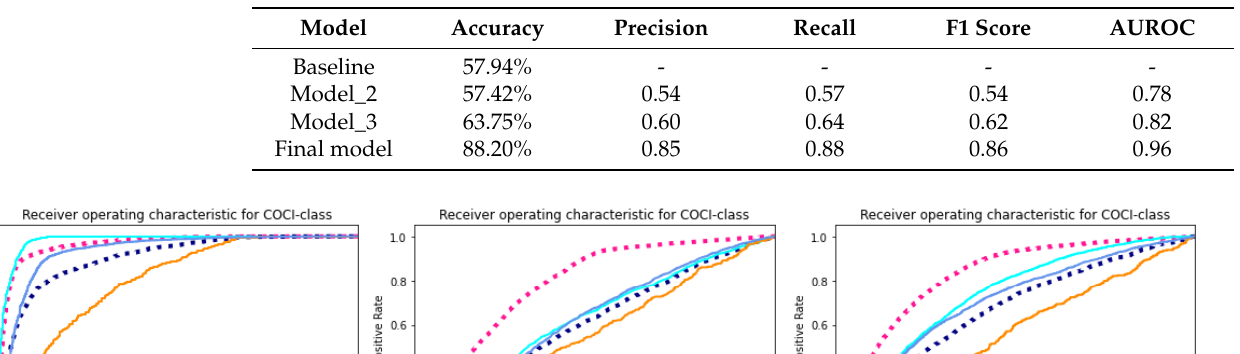
Table 6. Performance results between the final and compared models.